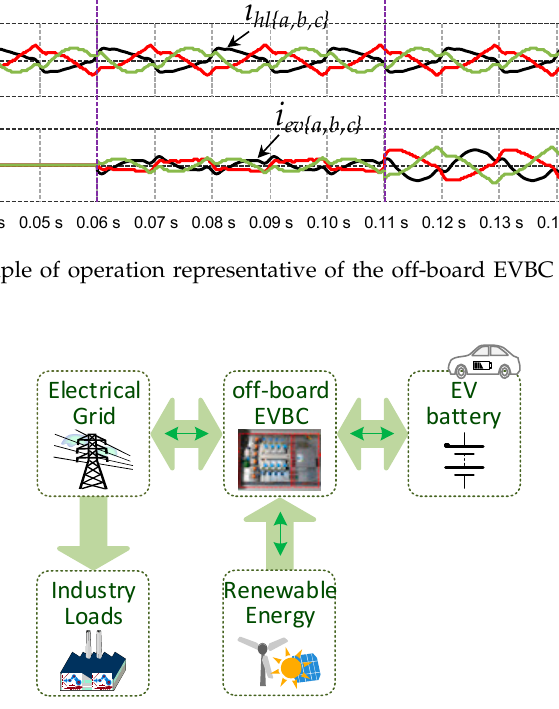
Figure 17. Off-board EVBC: Unified operation as a power quality compensator with